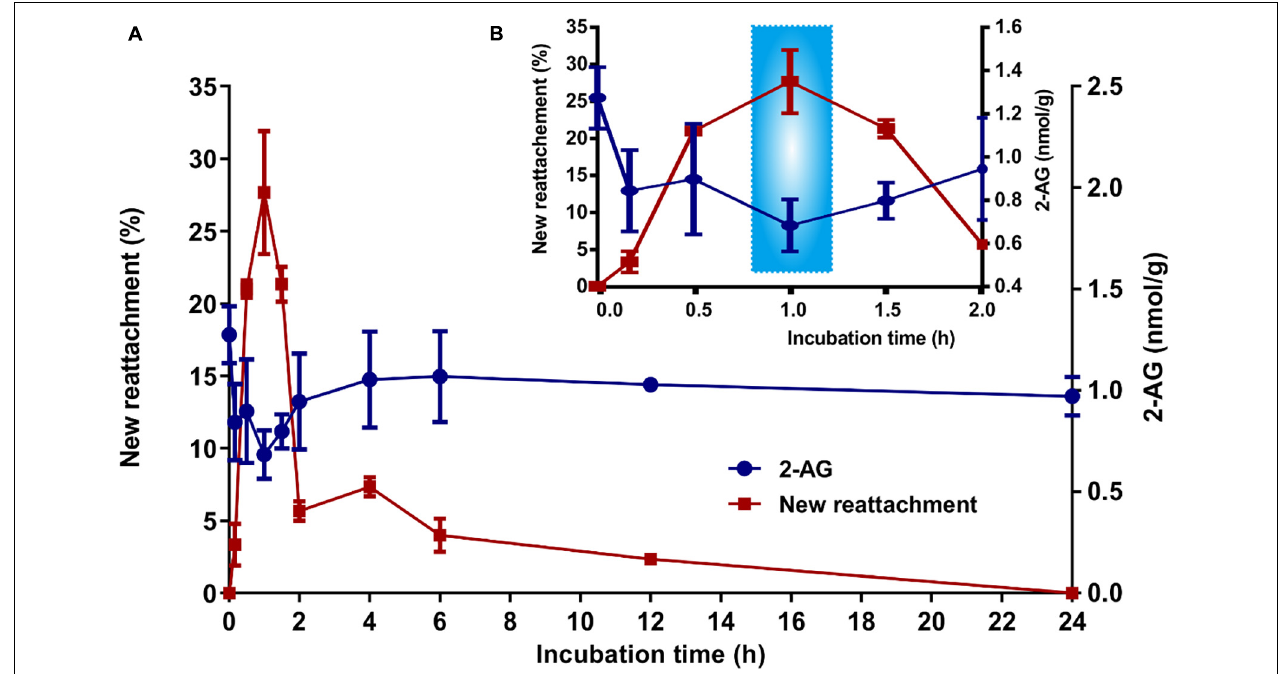
FIGURE 2 | Changes in the content of 2-AG in P. viridis during attachment. The level of 2-AG in P. viridis is inversely correlated with reattachment activity. (A) Changes in P. viridis reattachment and content of 2-AG during the first 24 h of incubation after removal of the byssus. (B) The enlarged view during the first 2 h. Data shown are means ± SE of replicates ( n =